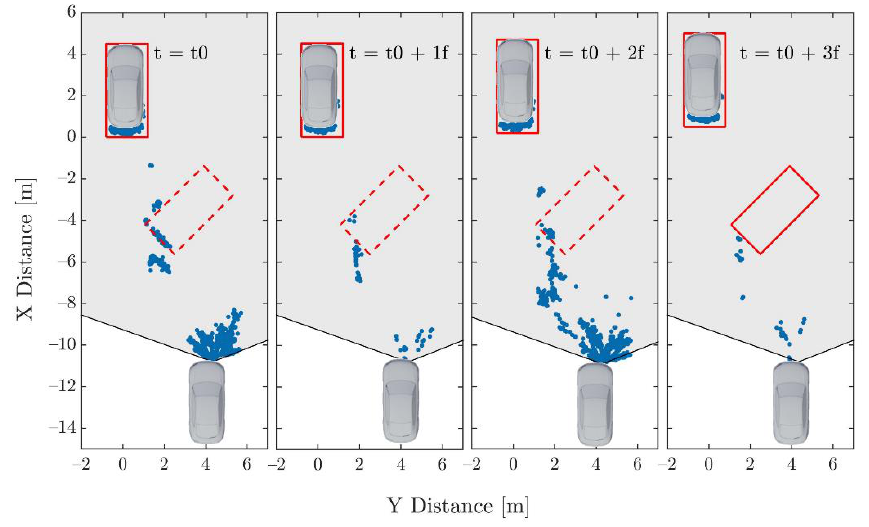
Figure 1. Bird’s eye view of a sequence in which a ghost object is generated due to spray water. A wrong object hypothesis created at the beginning (dashed line) is not rejected in subsequent frames; as a consequence, an extra object is generated (solid line). The field of view of the sensor is shown in light grey (based on [10]).